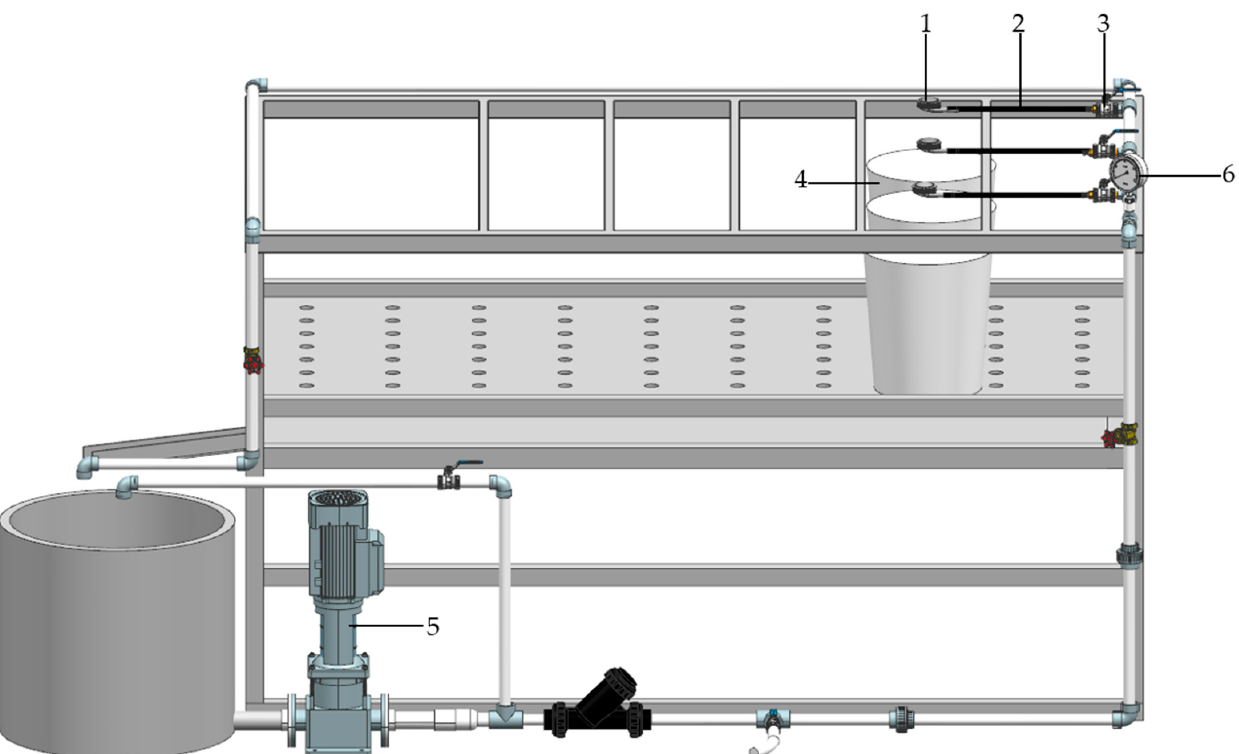
Figure 3. Schematic diagram of the hydraulic experimental platform of the AFV. 1. Automatic flushing valve; 2. PE pipe; 3. ball valve; 4. bucket; 5. centrifugal pump; and 6. pressure gauge.